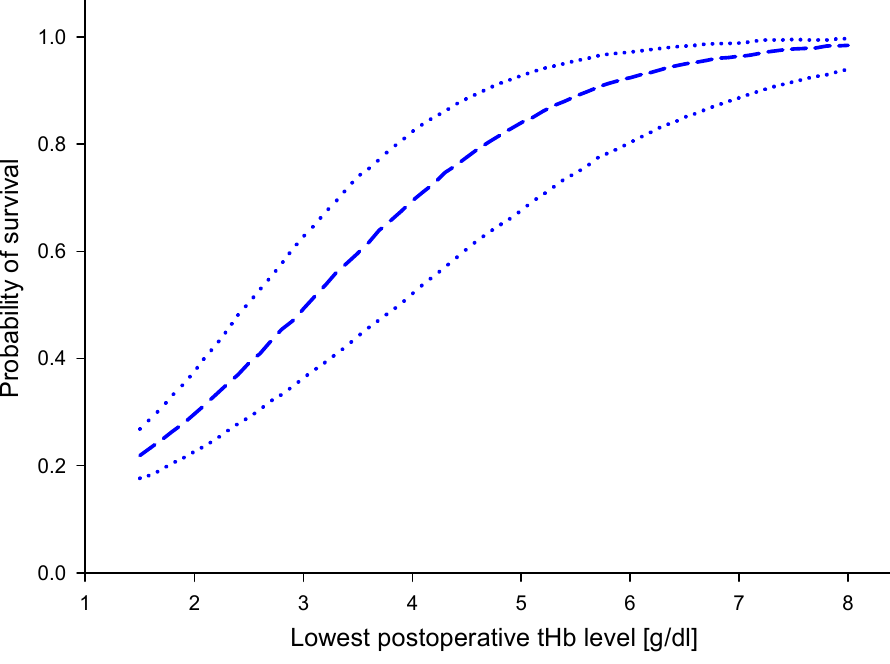
Figure 8. Probability of survival according to lowest postoperative tHb level, based on regression models and simulated data (dashed line), adapted from [59], dotted lines represent upper and lower 95% confidence interval of the pooled data.